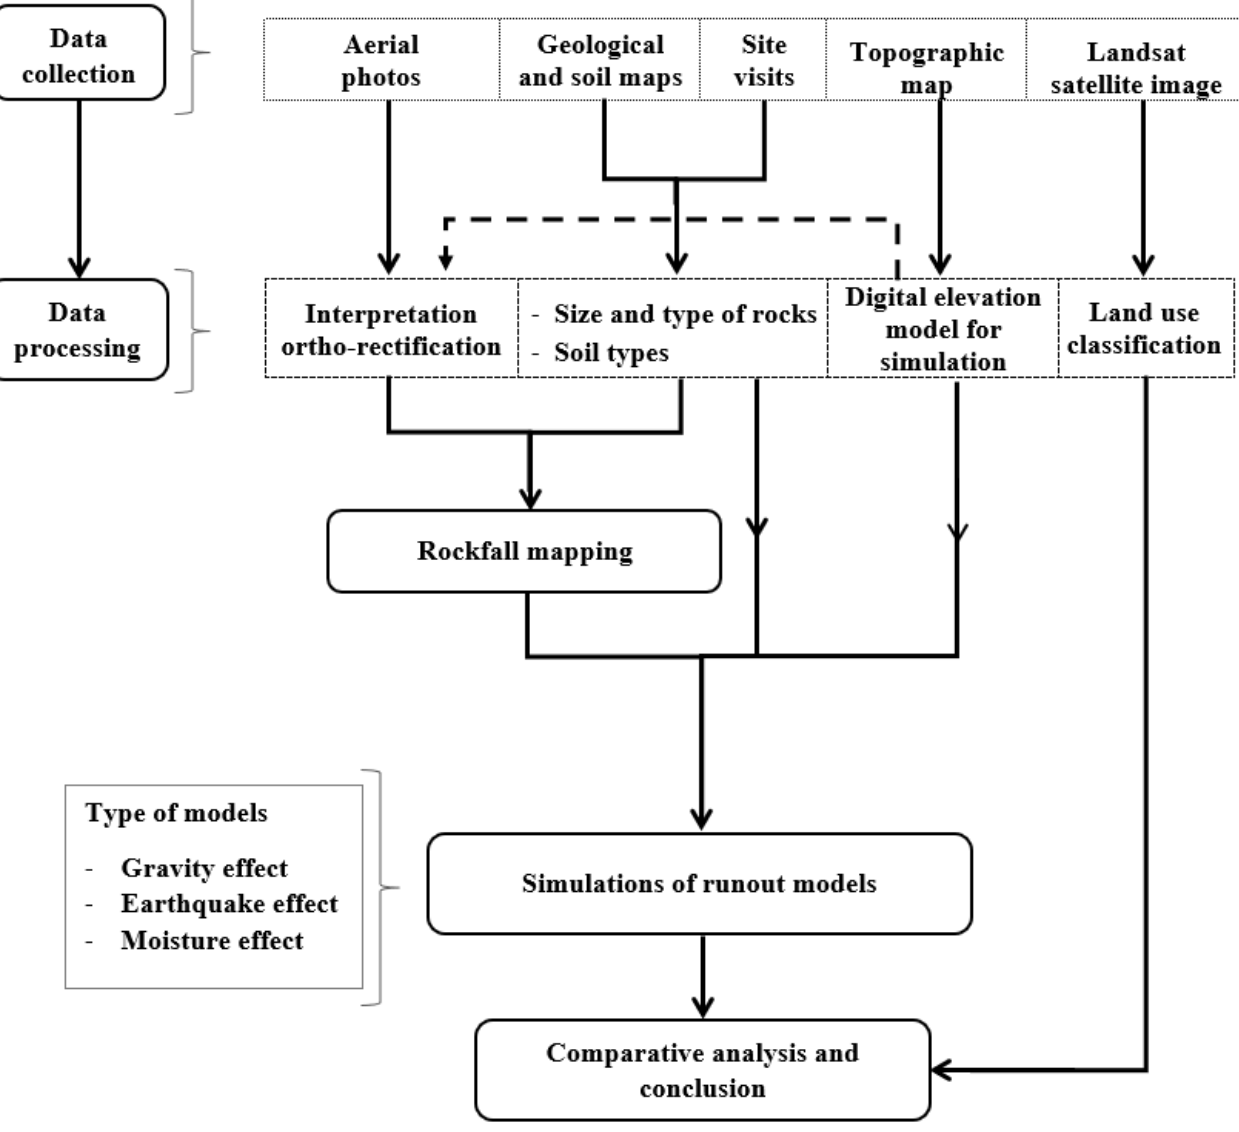
Figure 5. Developed methodology.